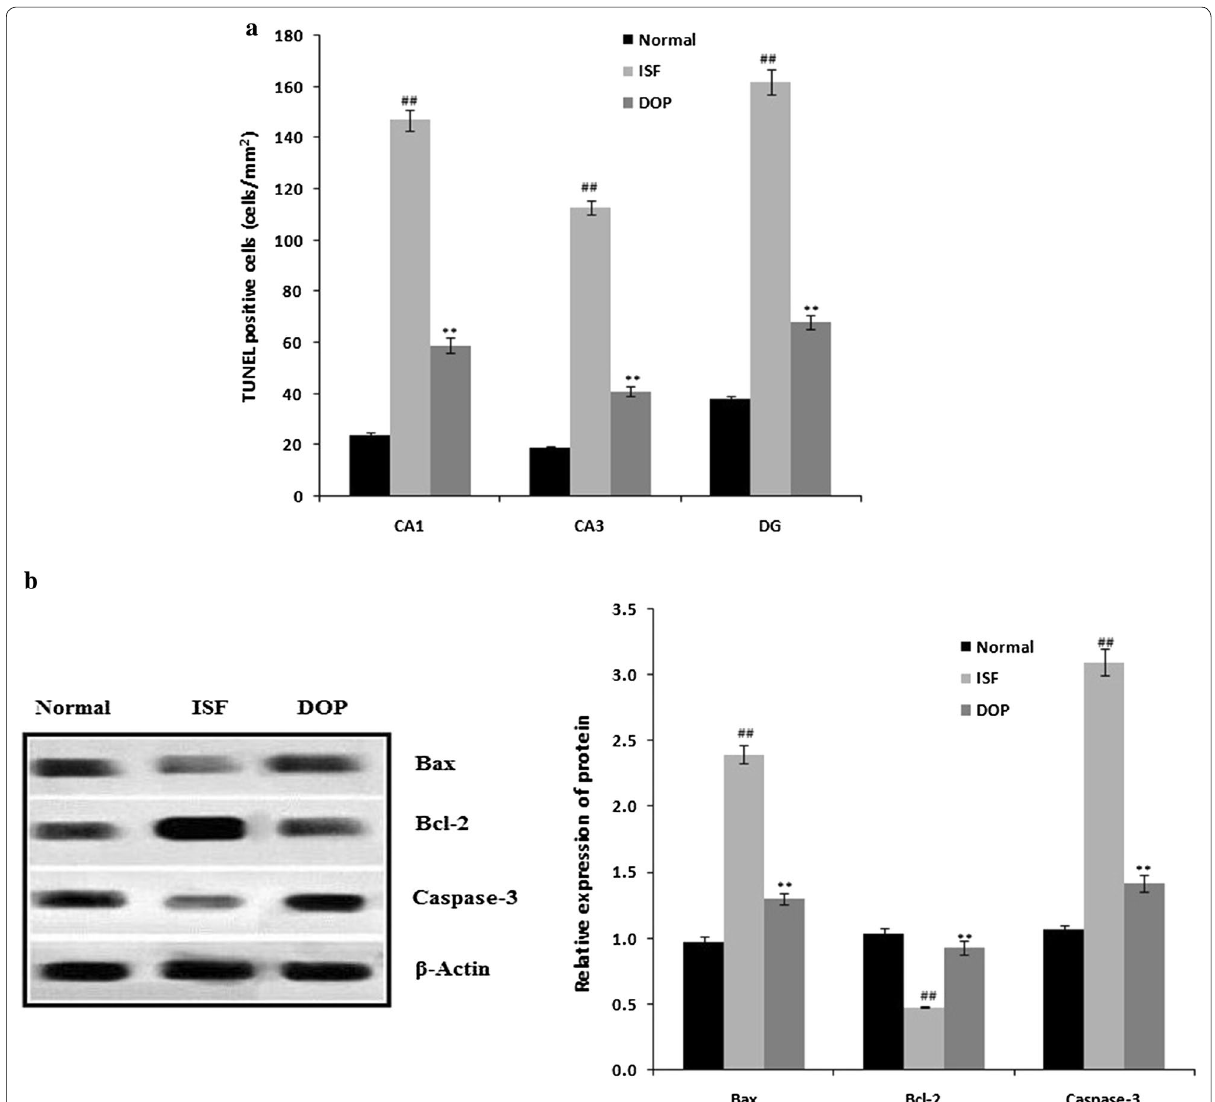
Fig. 3 Desoxyrhapontigenin ameliorates neuronal apoptosis in the brain tissues of rats with anaesthesia-induced neuronal injury. a TUNEL-positive cells; b Protein expression of caspase-2, Bcl-2, and Bax by Western blotting.